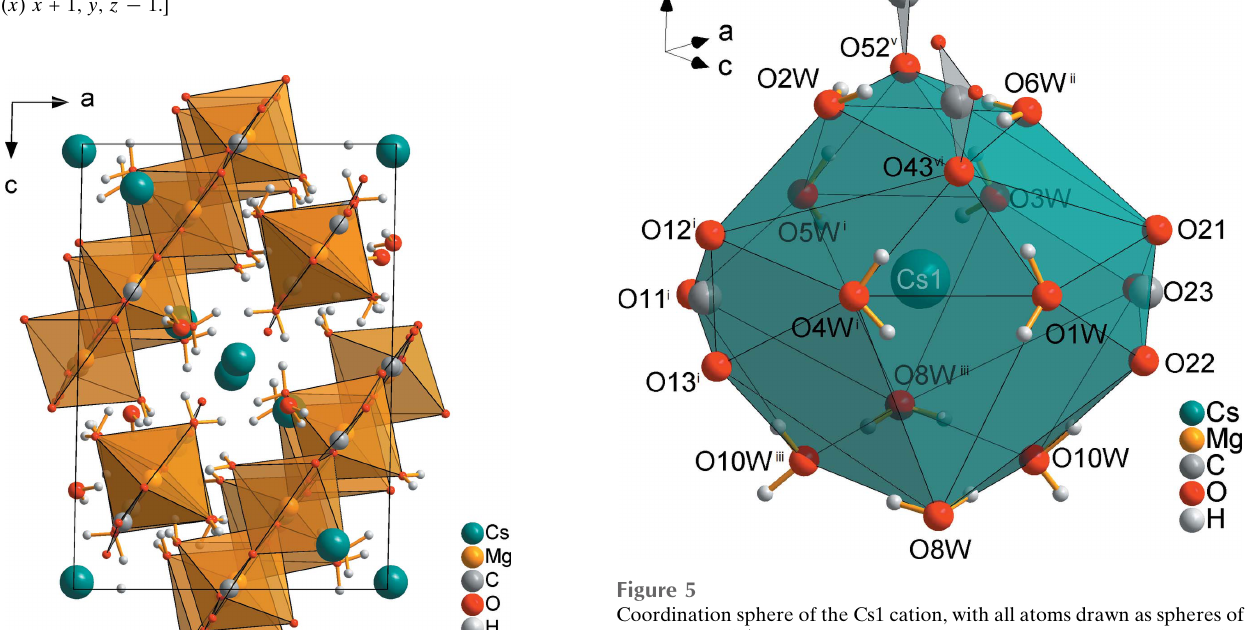
coordinated, in this case by three water molecules and two carbonate anions (C4, C5) in a monodentate and a bidentate fashion, respectively (Fig. 1). The 1 double chains and the isolated [Mg(H alternating sheets parallel to (010) (Fig. 4). , (cid:4) y + 3 , z + 1 ; (v) x + 1 , (cid:4) y + 3 , 2 2 2 2 2